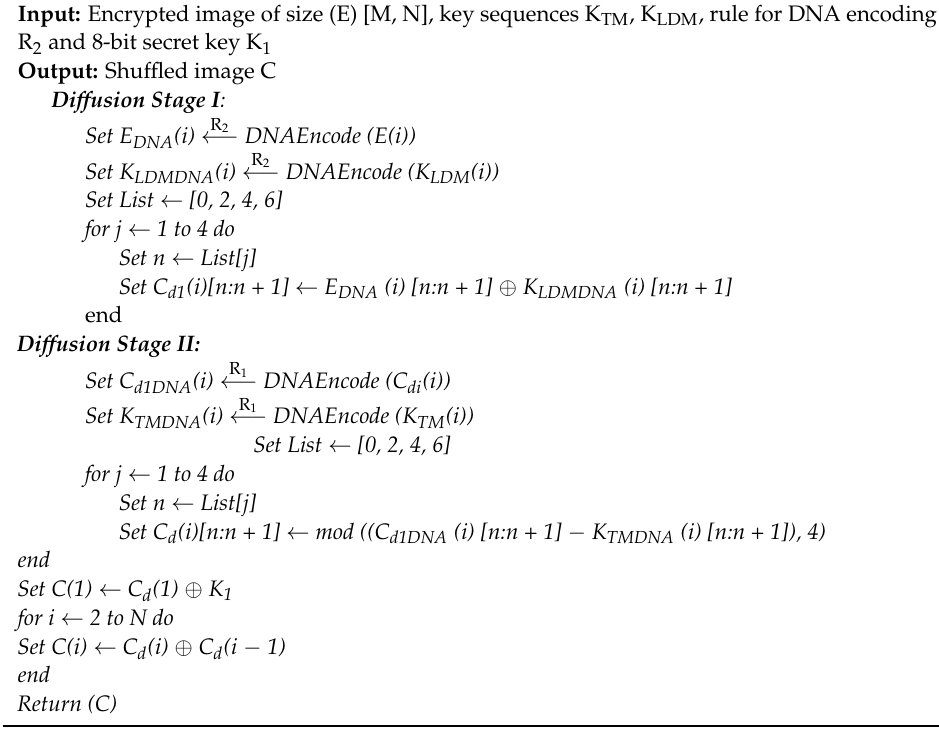
Algorithm 6: Image decryption—cipher block chaining process